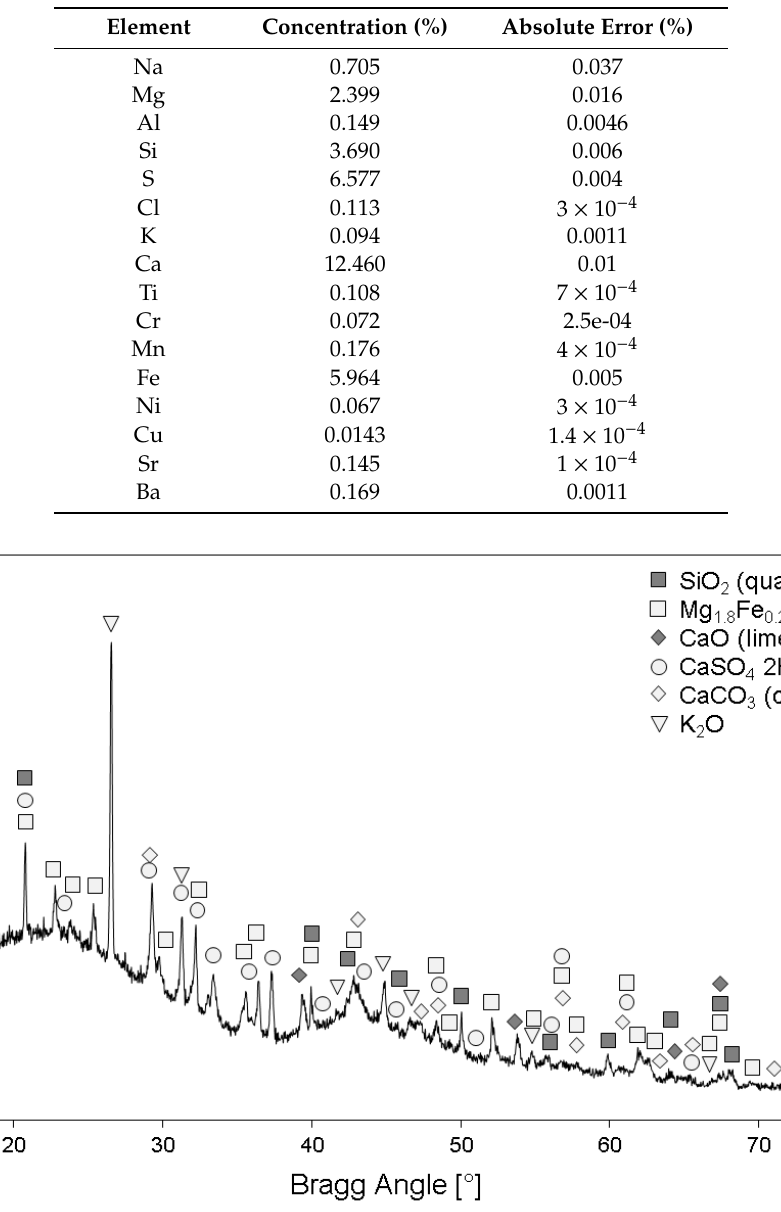
Figure 6. XRD analysis of lignite ash .